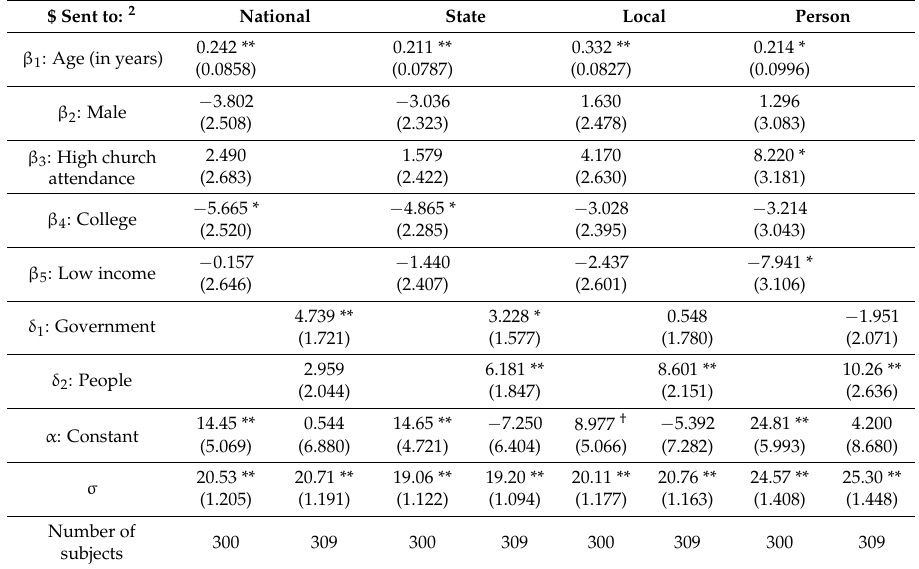
Table A2. Tobit results for comparative dictator game, by level, alternative specifications.